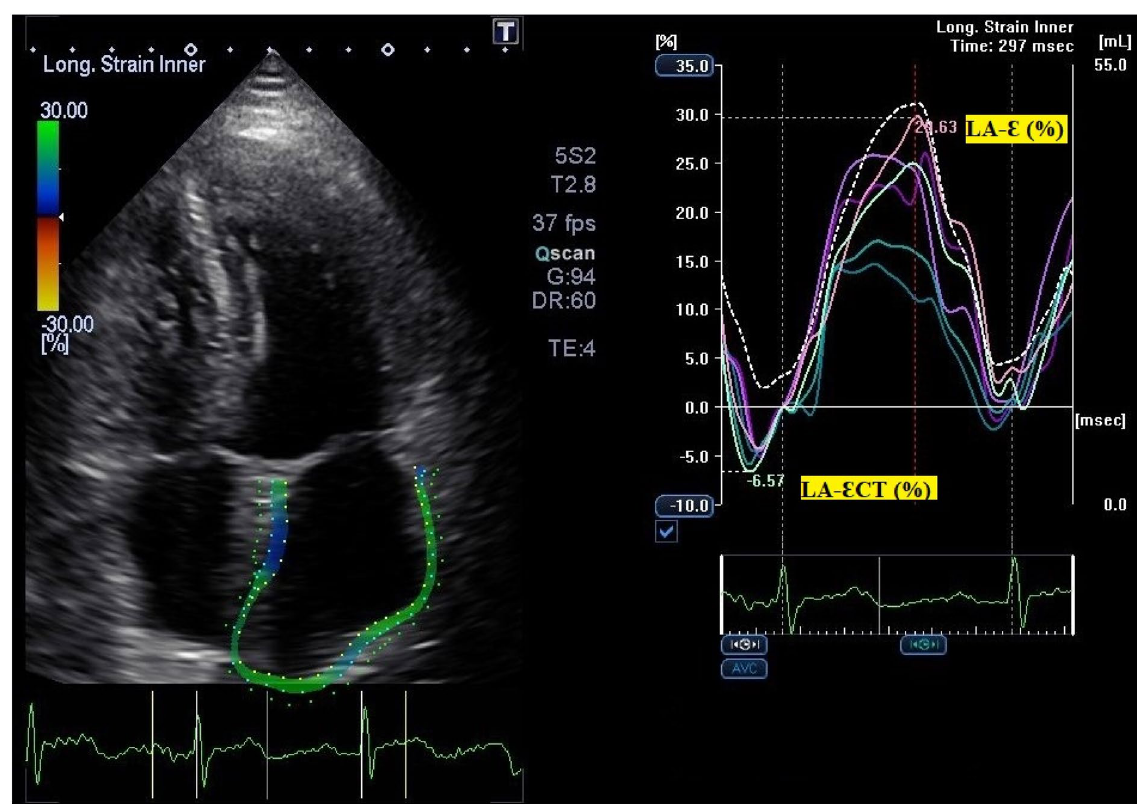
Fig. 1 Left atrium strain example with reservoir ( Ɛ ) and contraction ( Ɛ CT) functions